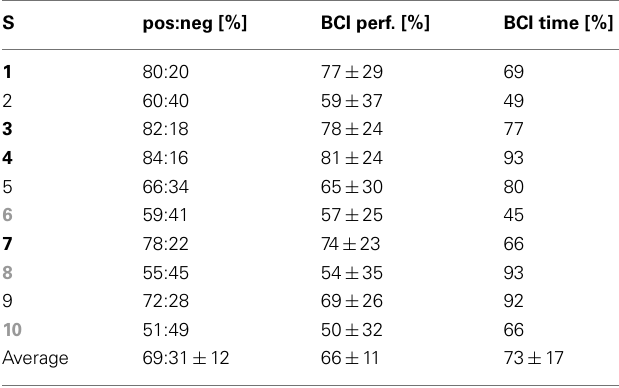
Table 3 |Time in BCI mode in relation to BCI performance and object collection rate (pos:neg).